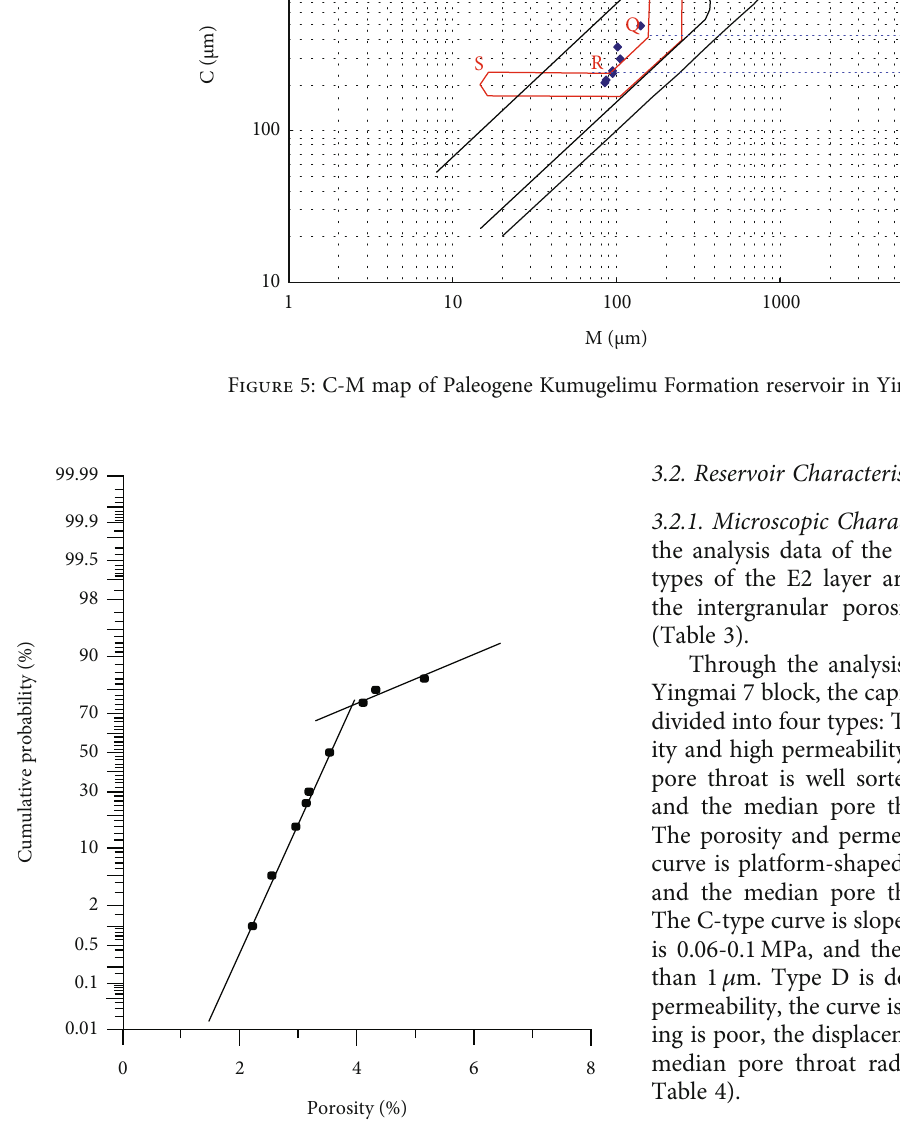
Figure 6: Reservoir particle size probability curve of Paleogene Kumugelimu Formation in block Yingmai 7.